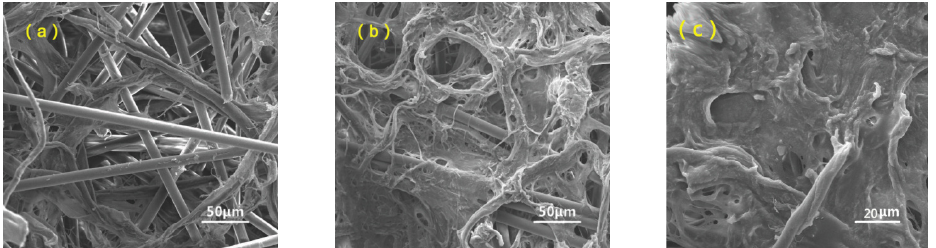
Figure 8. SEM of modified PP/PAN/cotton fibers composite membrane: ( a ) before thermal treatment; ( b , c ) after thermal treatment.